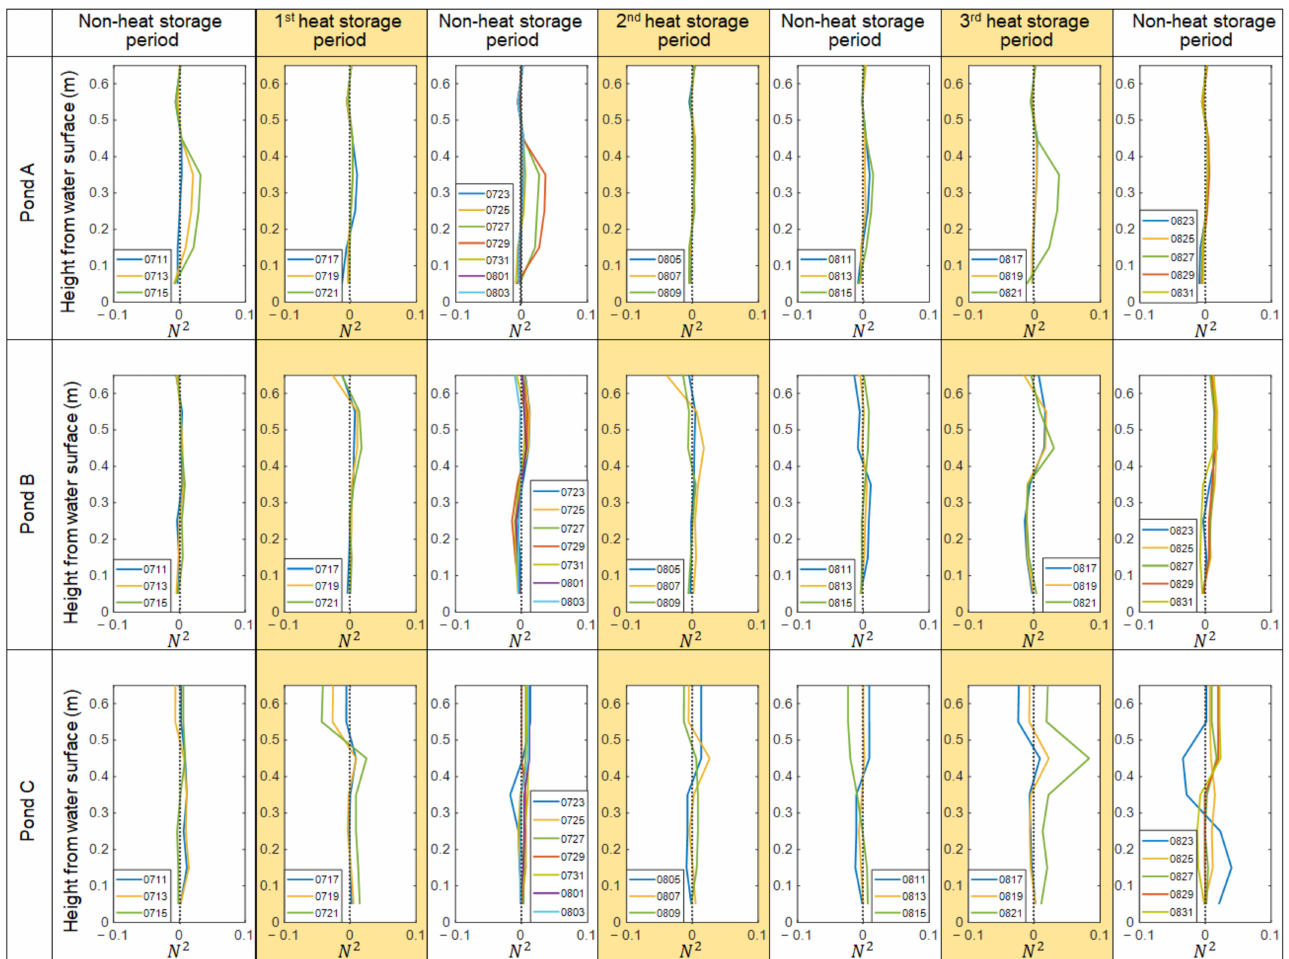
Figure 7. Vertical distribution of N 2 at midnight (AM 0:00), divided into periods. Colored parts indicate heat storage periods in Pond